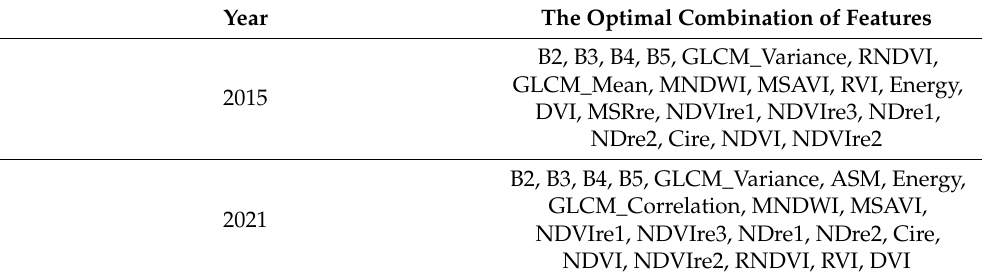
Table 4. The optimal feature variable sets for 2015 and 2021.